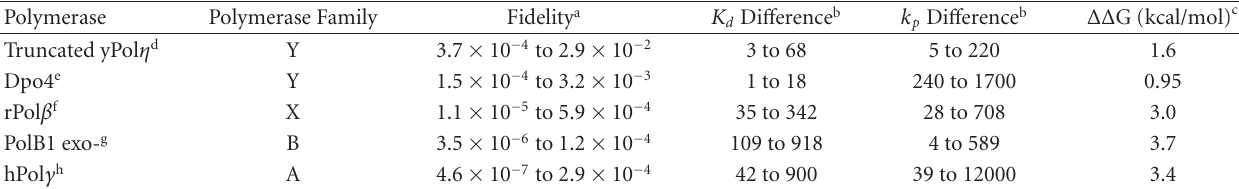
Table 6: Comparison of base substitution fidelity for various DNA